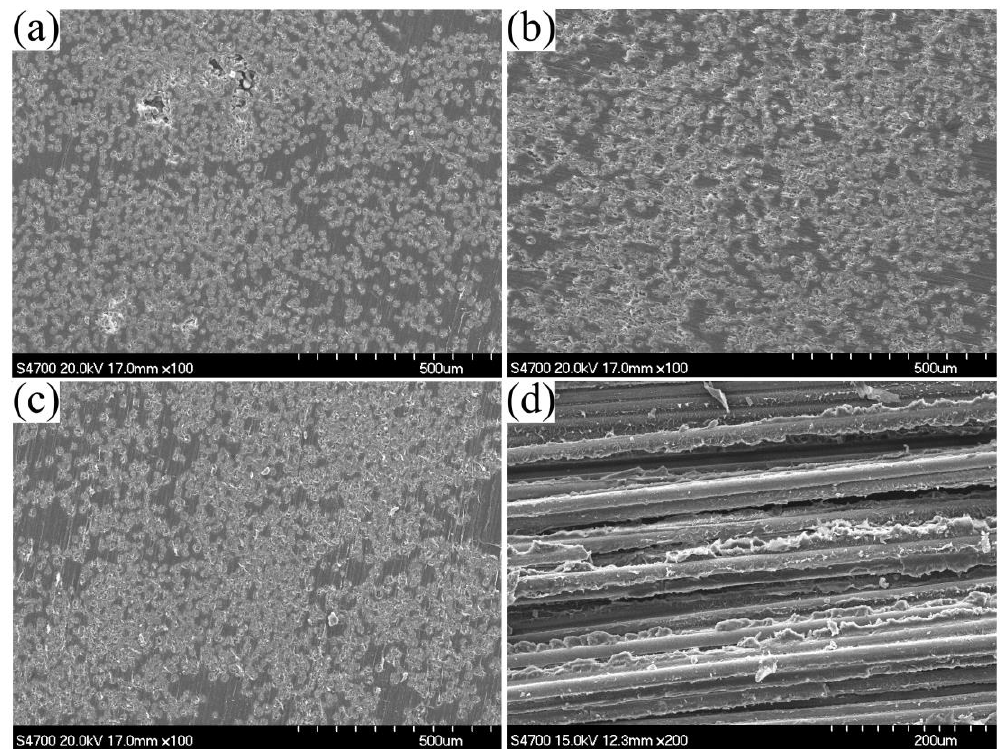
Figure 12. SEM micrographs of the pultruded composites: ( a ) cross sections with 50 wt% glass fibers, ( b ) cross sections with 60 wt% glass fibers, ( c ) cross sections with 70 wt% glass fibers, and ( d ) fracture surfaces with 70 wt% glass fibers, all at a heating zone temperature of 180 °C.